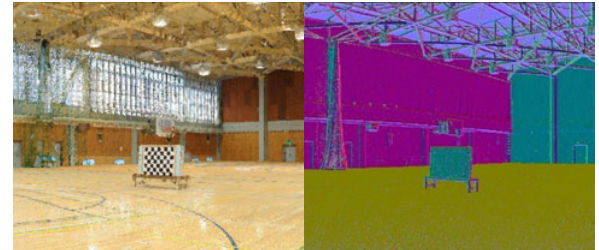
Figure 1. Point cloud clustering: colored point cloud (left image) and clustered point cloud (right image) There are three clustering approaches in point-cloud clustering: model-based clustering (Boyko et al. 2011), edge-based clustering (Jiang et al. 1999), and region-based clustering (Vosselman et al. 2004). Model-based clustering requires CAD models to estimate simple objects or point clusters from the point cloud. In 3D industrial modeling, standardized objects, such as pipes and parts, are prepared as CAD models in advance. However, the CAD model preparation approach is unsuitable for modeling unknown objects. On the other hand, edge-based and region-based clustering are often used to model unknown objects (Tsai et al. 2010). These approaches also focus on geometrical knowledge (Pu, et al. 2009) and 2D geometrical restrictions, such as the depth from a platform (Zhou, et al. 2008) and discontinuous point extraction on each scanning plane from the mobile mapping system (Denis et al. 2010) to extract simple boundaries and features in urban